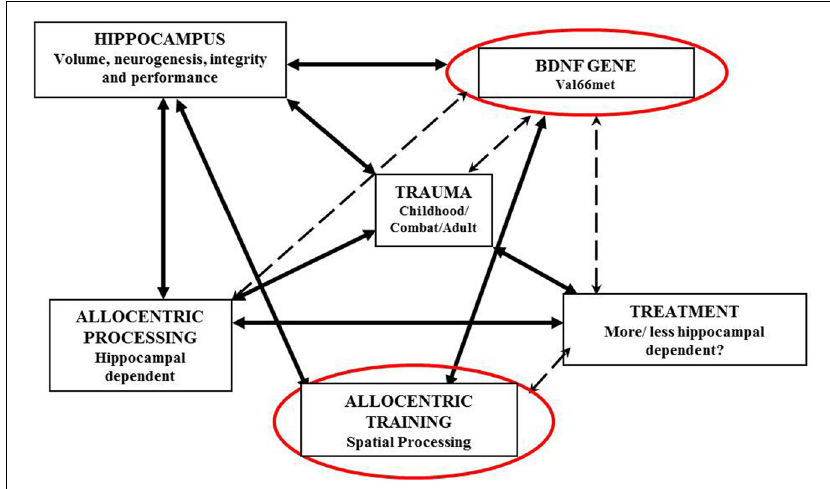
FIGURE 1 | From DNA to treatment success: BDNF, the hippocampus, spatial, and trauma processing.